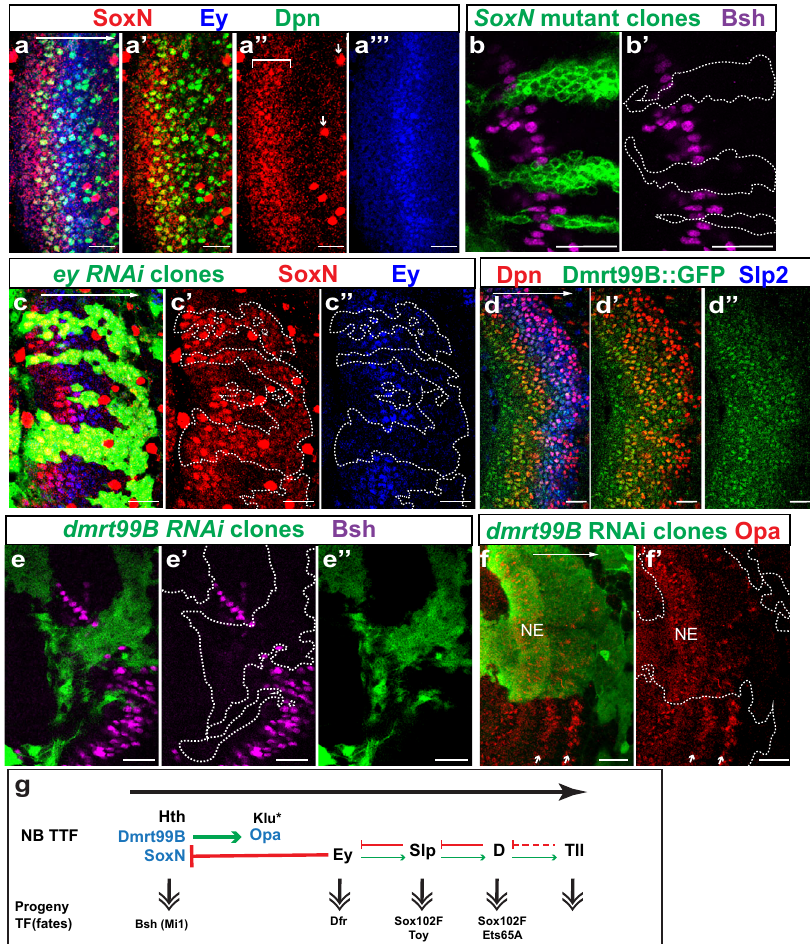
Fig. 2 SoxN and Dmrt99B are two TTFs that function together with Hth in the fi rst temporal stage. In all images of this and the following fi gures, lateral is to the left, and medial is to the right. The large white arrow from left to right indicates the NB age from the youngest to the oldest. White dashed lines indicate clone margin unless otherwise noted. a – a ”’ SoxN protein (red) is expressed before NB formation and in the youngest NBs (marked by Dpn in green) before Ey (blue), and this expression domain is indicated by a white bracket. SoxN is also expressed in glial cells, and examples are indicated by small white arrows. b , b ’ In SoxN NC14 mutant clones marked by GFP (green), Bsh (magenta) is lost (in 12 out of 12 clones). c – c ” In ey-RNAi clones marked by GFP (green), Ey (blue) is lost, and SoxN (red) expands into older NBs (in 11 out of 11 clones). d – d ” Dmrt99B::GFP (green) is expressed before NB formation and in the young NBs (NBs marked by Dpn in red) until early Slp (blue) stage. e – e ” In Dmrt99B-RNAi clones marked by GFP (green), Bsh (magenta) is lost (in seven out of seven clones). f , f ’ In Dmrt99B-RNAi clones marked by GFP (green), Opa (red) is lost or greatly reduced (16 out of 16 clones). White arrows indicate the two stripes of Opa expression in NBs. g A schematic model showing the three NE TTFs and their cross-regulations with NB TTFs. Scale bars: 20 μ